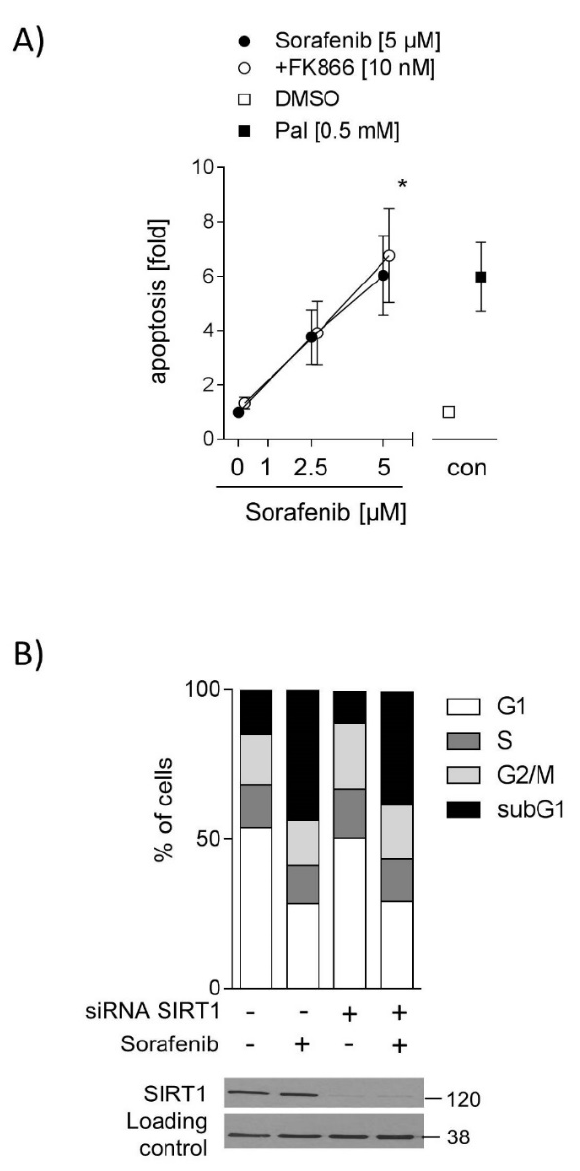
Figure 4. Inhibition of SIRT1 does not sensitize hepatocarcinoma cells to sorafenib ( A ) Cells were stimulated with sorafenib (2.5 µM and 5 µM) alone or in combination with FK866 (10 nM) for 24 h. Apoptosis was determined by FITC Annexin V Apoptosis Detection Kit and flow cytometry. Annexin V-FITC positive cells and Annexin-V-FITC and PI-positive cells were defined as apoptotic cells ( n = 3). DMSO serves as solvent control and palmitate (0.5 mM) as a positive control. The mean value of serum-free medium (0 µ M) was used to normalize values of the respective datasets. ( B ) SIRT1 protein levels were downregulated by SIRT1 siRNA using electroporation. Control cells were transfected with control siRNA. Cell cycle distribution was analyzed by PI staining to analyze DNA content. Data are shown as mean ± SEM. * p < 0.05.